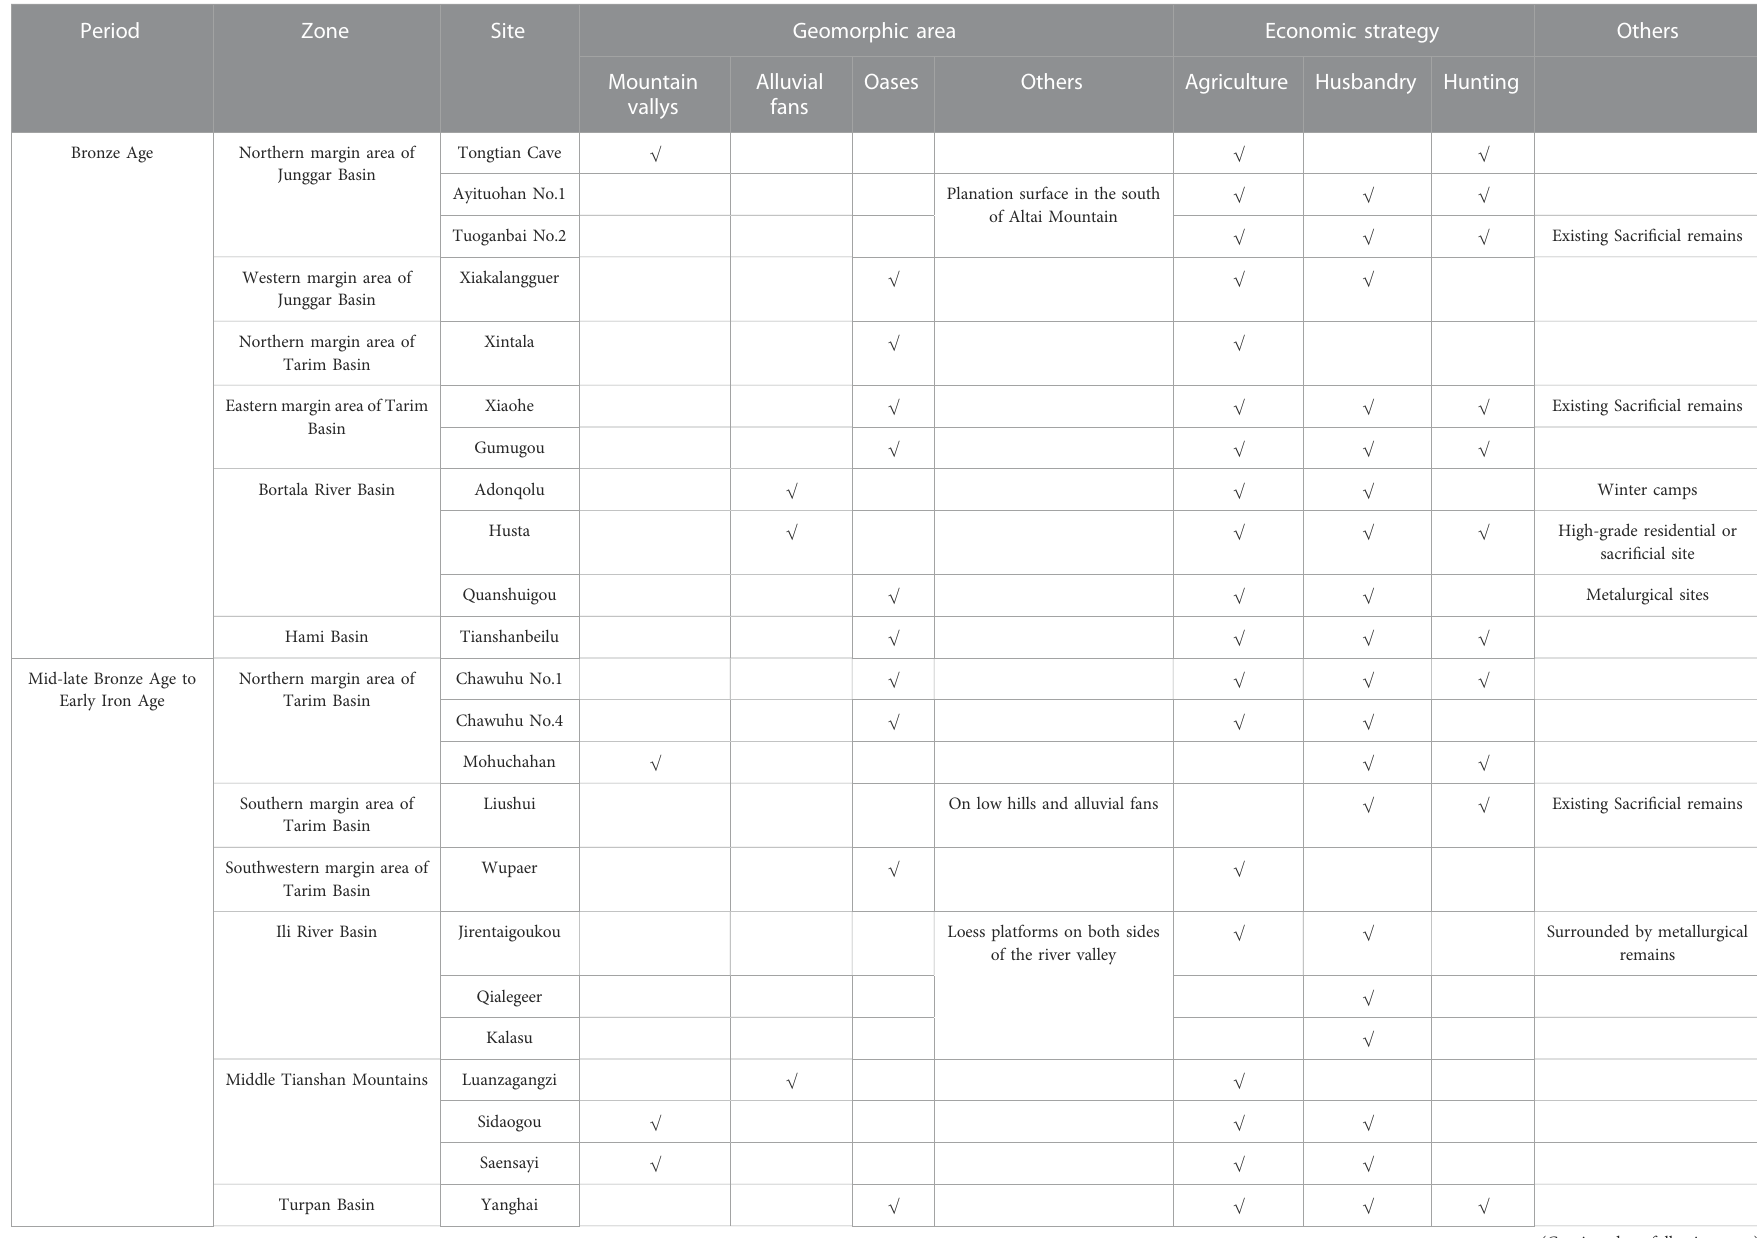
TABLE 2 Geomorphic area and economic strategy of important sites and